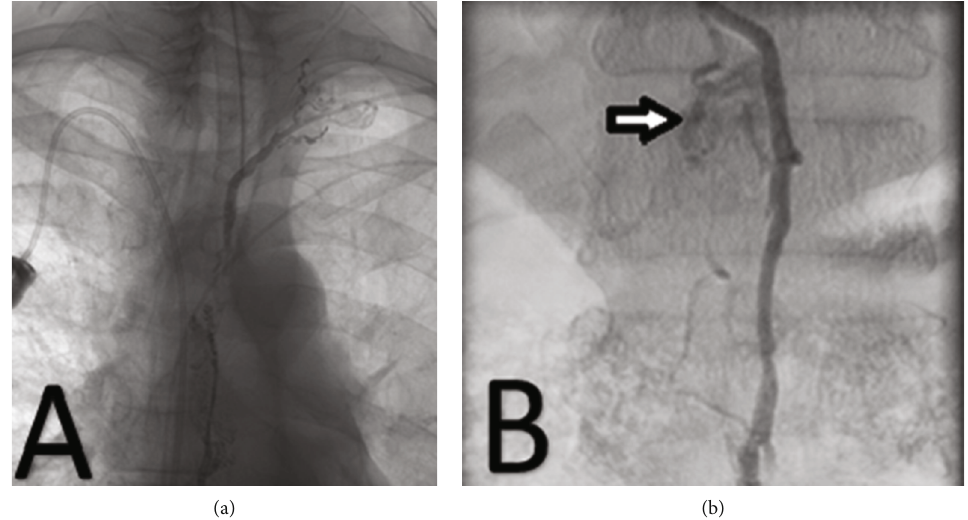
Figure 2: Thoracic (a) and abdominal (b) lymphangiogram delineating the thoracic duct using contrast dye; evidence of extravasation